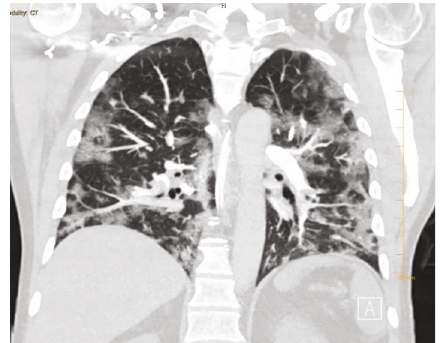
Figure 2: Chest computed tomography with contrast showing bilateral pulmonary emboli and multifocal lung consolidations.